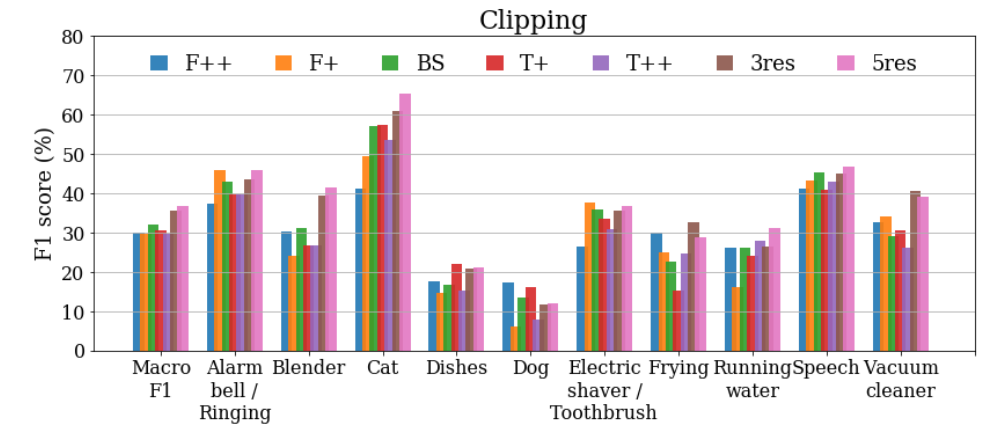
Figure 6. F 1 scores of single-resolution systems ( F ++ , F + , BS , T + , T ++ ) and multiresolution systems ( 3res , 5res ) over DESED Public Evaluation set applying clipping saturation. “Macro F1” shows average score over 10 target categories. Best viewed in